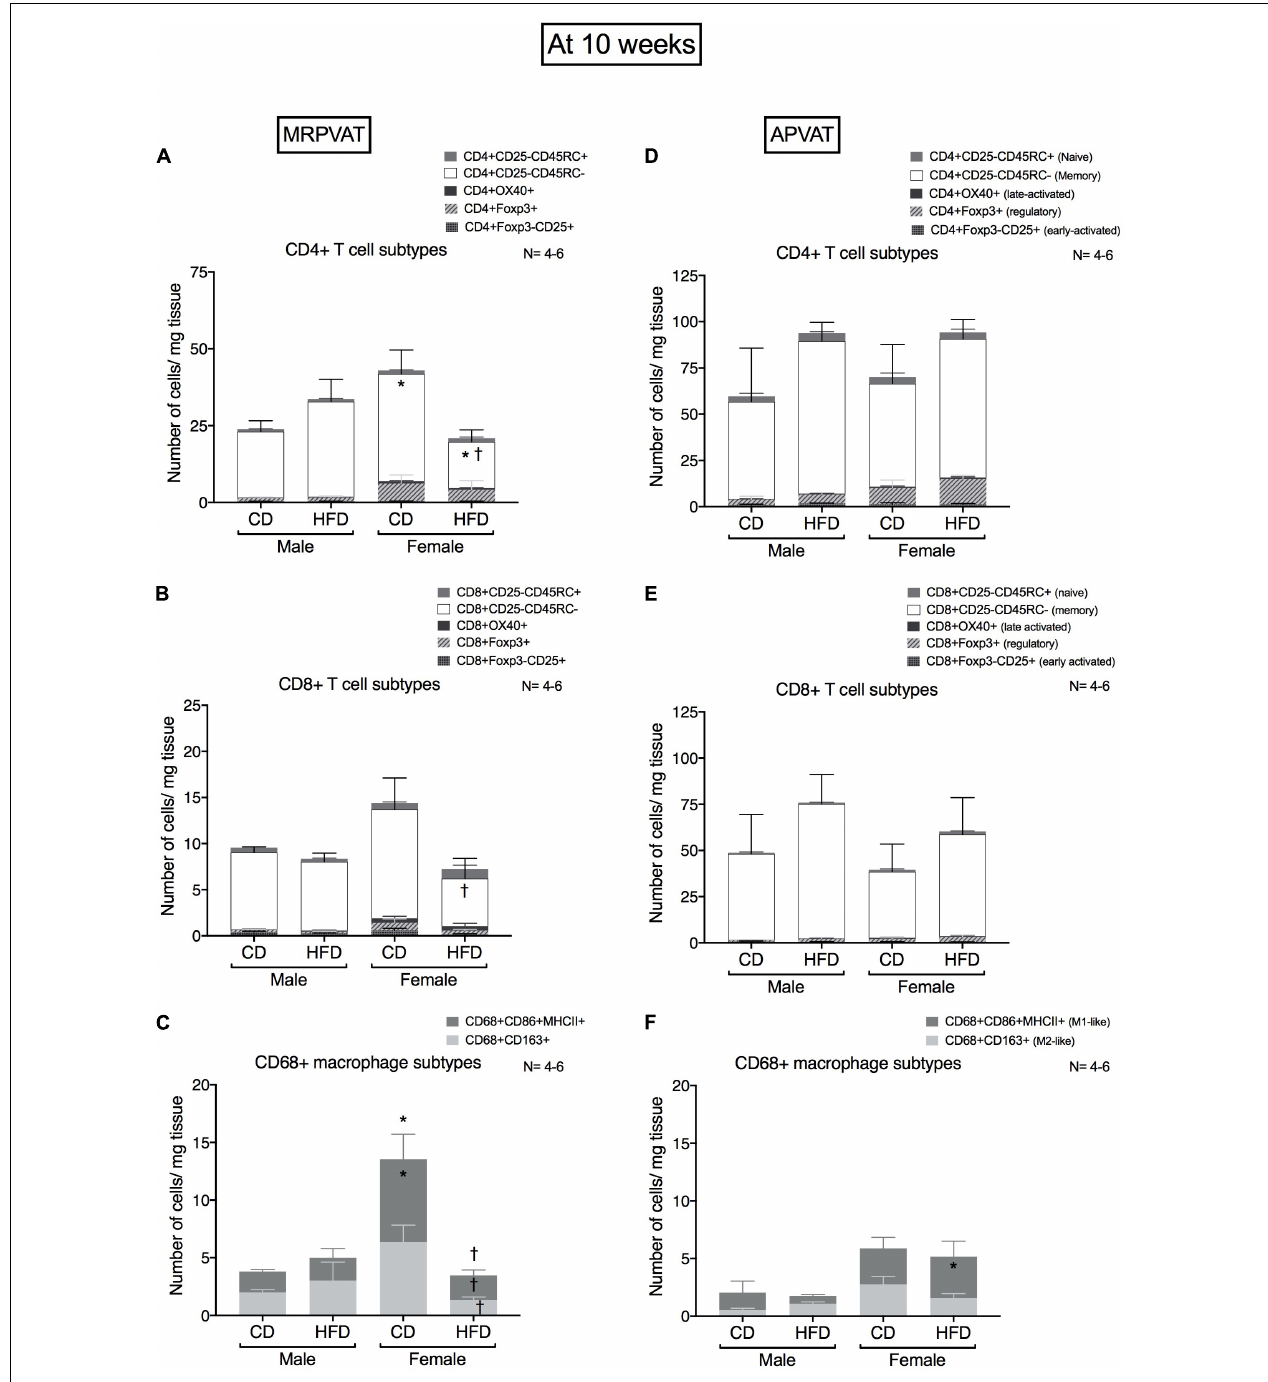
FIGURE 3 | Sex-differences in T cell and macrophage subtypes in PVATs before the development of hypertension. Subtypes of CD4+, CD8 + T cells and CD68+ macrophages in MRPVAT and APVAT of both sexes at 10 weeks on diet (before hypertension) were quantified by flow cytometry. Subtypes of CD4 + : CD4 + CD25 + , CD4 + OX40 + , CD4 + Foxp3 + , CD4 + CD45RC- and CD4 + CD45RC + cells (A,D) , CD8 + T: CD8 + CD25 + , CD8 + OX40 + , CD8 + Foxp3 + , CD8 + CD45RC- and CD8 + CD45RC + cells (B,E) , and CD68 + CD68 + CD163 + and CD68 + CD86 + MHCII + macrophages (C,F) were measured. Bars represent means ± SEM for the absolute cell counts of each immune cell type, normalized to tissue weight (in milligram). Number of animals is indicated by N. A P < 0.05 by two-way ANOVA with Tukey’s test for multiple comparison, was considered statistically significant. * and † inside/outside the stacks in the graph represent a significant difference in the specific stack of immune cells/sum total of immune cells between the sexes within each diet and between the diets within each sex respectively.